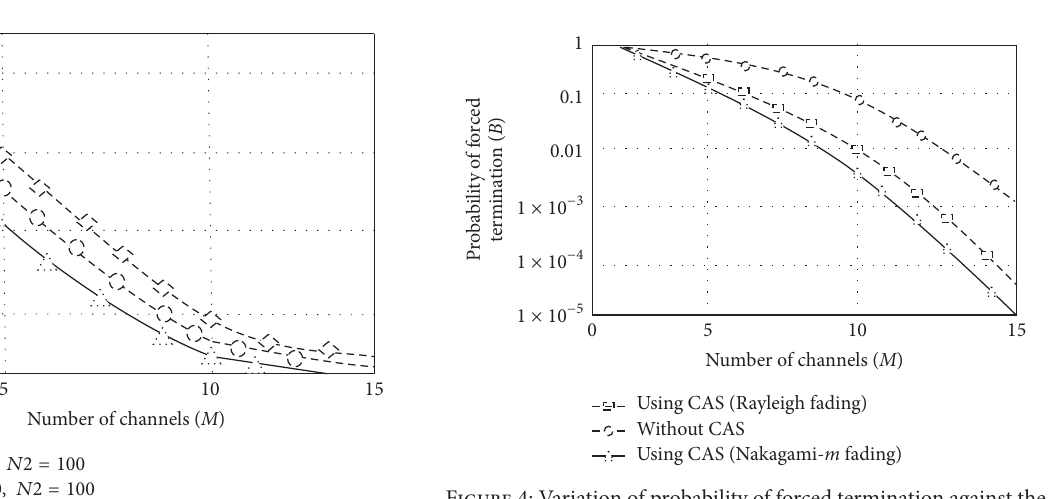
Figure 1: Variation of blocking probability against the offered traffic of newly originating call.